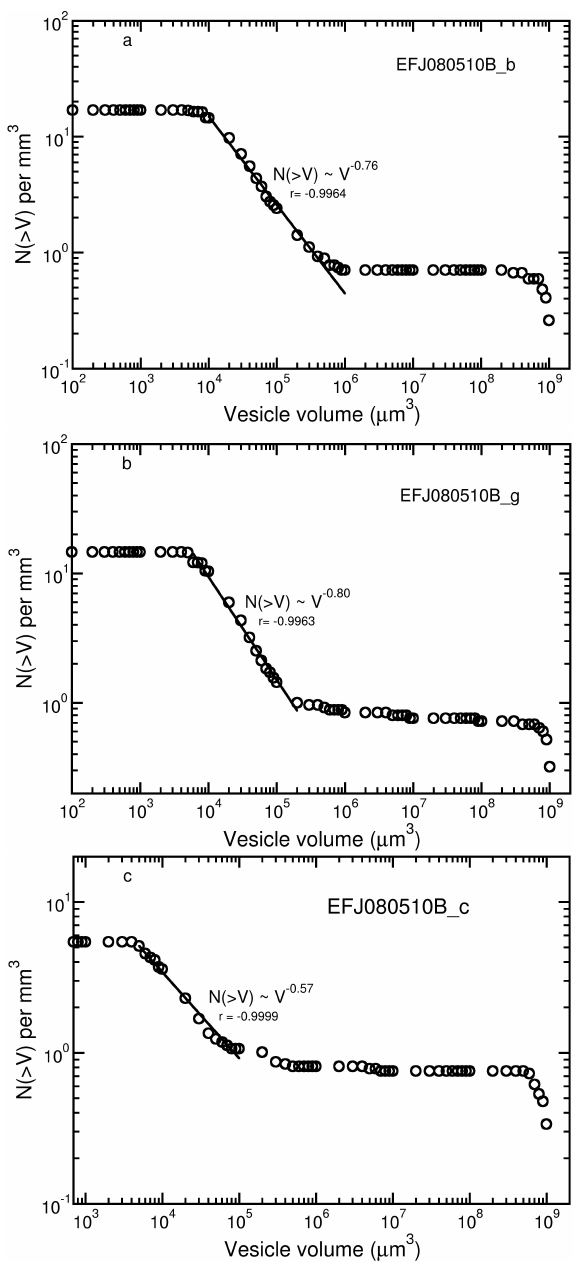
Fig. 2. Examples of cumulative vesicle size distributions in natu- ral samples. (a) Natural sample EFJ050810B_b with a vesicular- ity of 65.5% and a VND of 17.0 per mm 3 . (b) Natural sample EFJ050810B_g with a vesicularity of 72.3% and a VND of 14.6 per mm 3 . (c) Natural sample EFJ050810B_c with a vesicularity of 77.6% and a VND of 5.4 per mm 3 . In each panel the open cir- cles are the cumulative vesicle volume distributions per mm 3 , and the lines are power-law fits (using the software package Grace) to vesicle volumes between approximately ∼ 10 4 and 10 5 µm 3 . All other natural cumulative vesicle size distributions can be found in the Supplement.